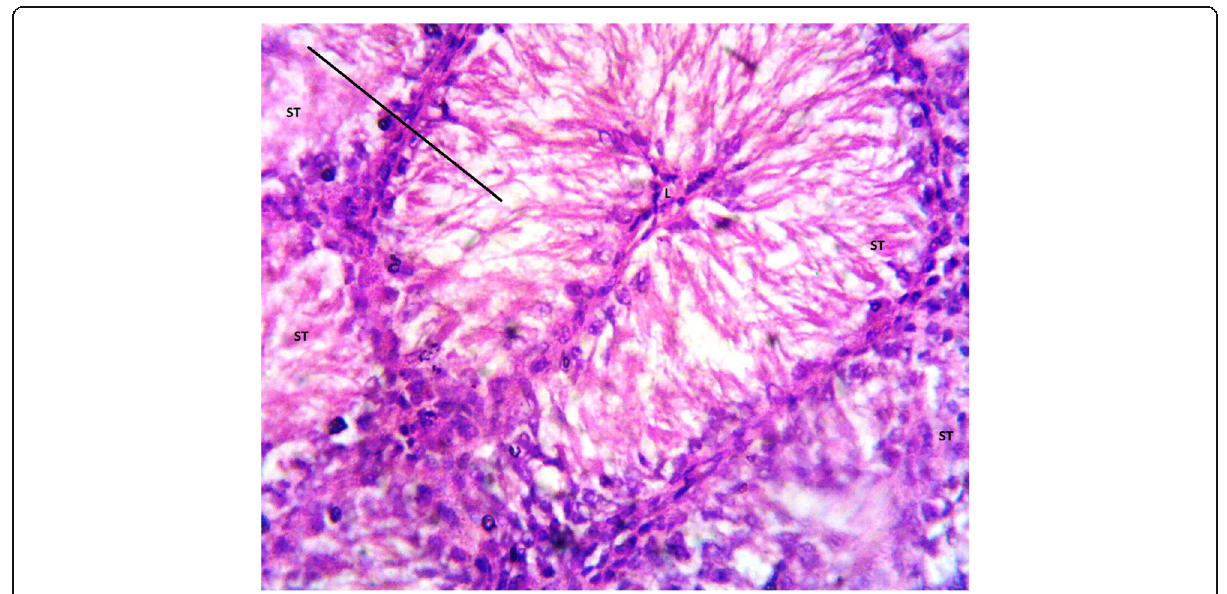
Fig. 9 Representative micrograph of testis section (× 400) of broiler chicks fed 0.4% PCM supplemented diet. This section shows reduced